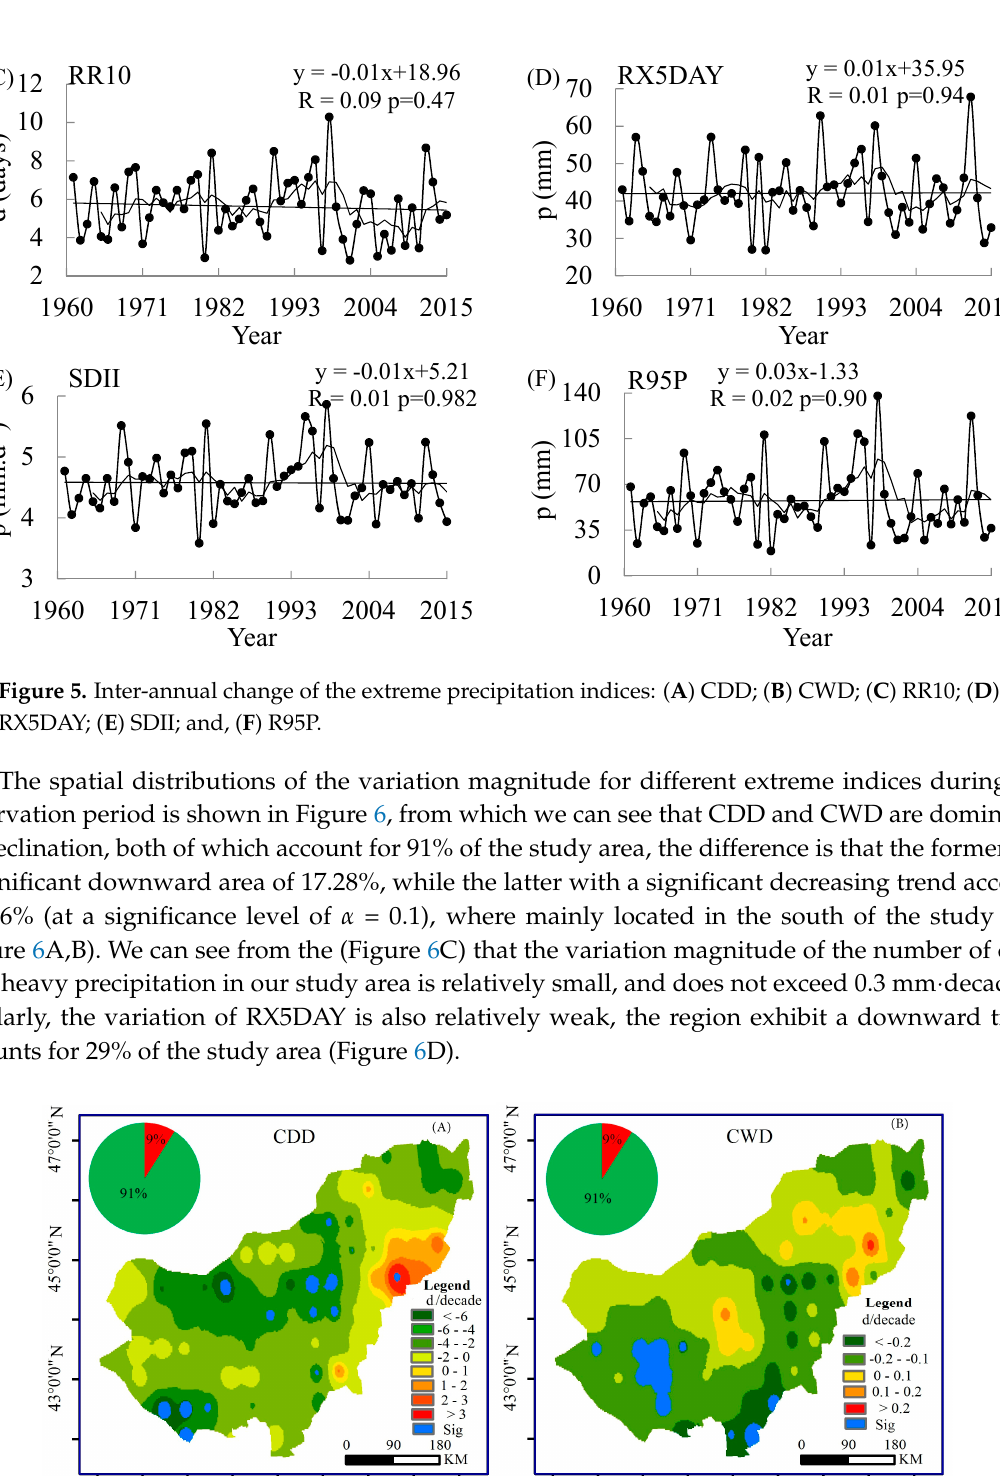
Figure 5. Inter-annual change of the extreme precipitation indices: ( A ) CDD; ( B ) CWD; ( C ) RR10; ( D ) RX5DAY; ( E ) SDII; and, ( F ) R95P.